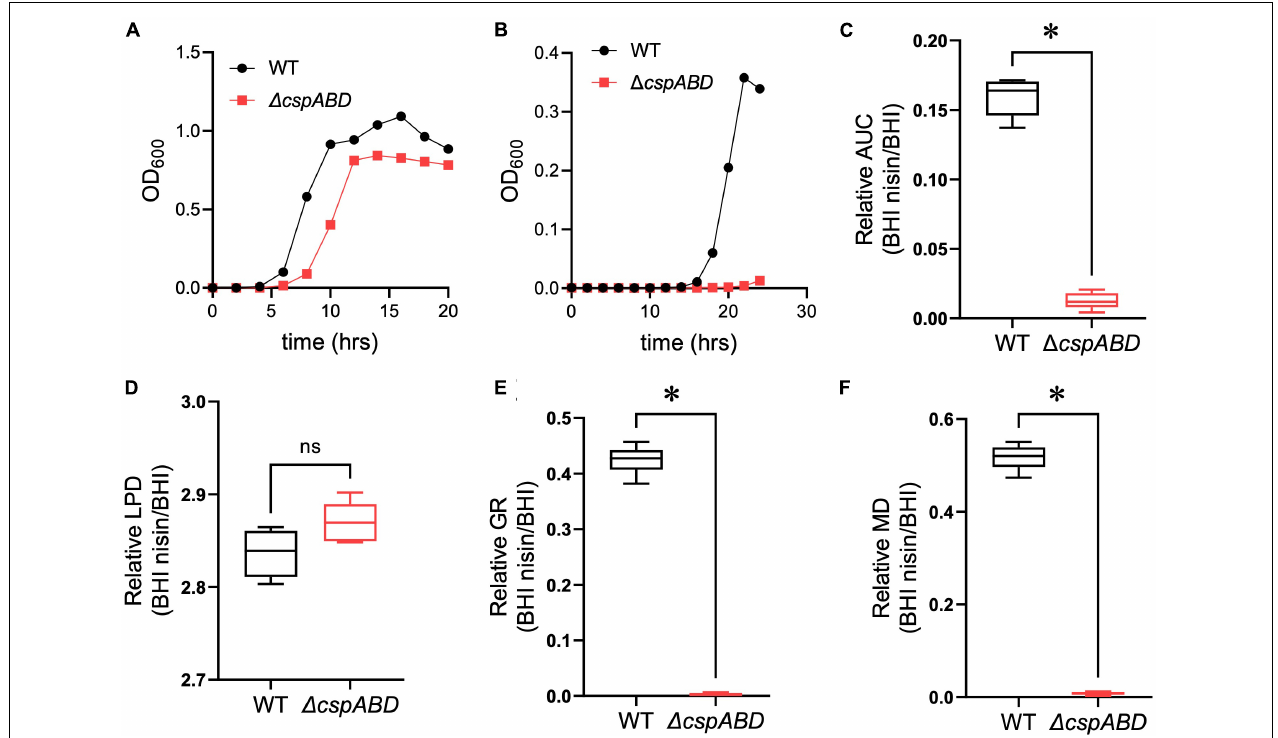
FIGURE 1 | Csp deficiency severely impairs nisin stress growth efficiency in L. monocytogenes . (A,B) Optical density measurement-based growth curves of L. monocytogenes EGDe wild-type (WT) and (cid:49) cspABD strains cultivated (37 ◦ C and 150 rpm) in (A) normal and (B) nisin (5 ppm)-supplemented BHI. (C–F) Box plots summarizing the relative nisin stress growth parameters (area under the curve, lag phase duration, growth rate, and maximum cell density) of EGDe WT and (cid:49) cspABD strains normalized for each strain to the growth parameters of controls grown in BHI without stress. ∗ P < 0.05, significant differences between the WT and (cid:49) cspABD strains identified using the t -test for comparison of independent